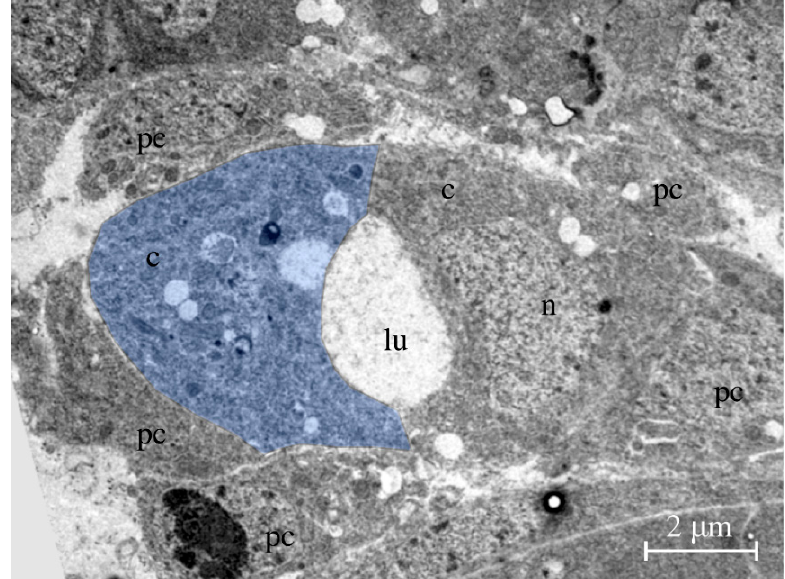
Figure 3. Transmission electron micrograph. The picture shows a cross-section through the heart of a late-stage 16 embryo. Two bean-shaped cardiomyocytes form the heart lumen. One of the two cardiomyocytes is labeled in blue. Abbreviations: c, cardiomyocyte; lu, lumen; n, nucleus; pc, pericardial